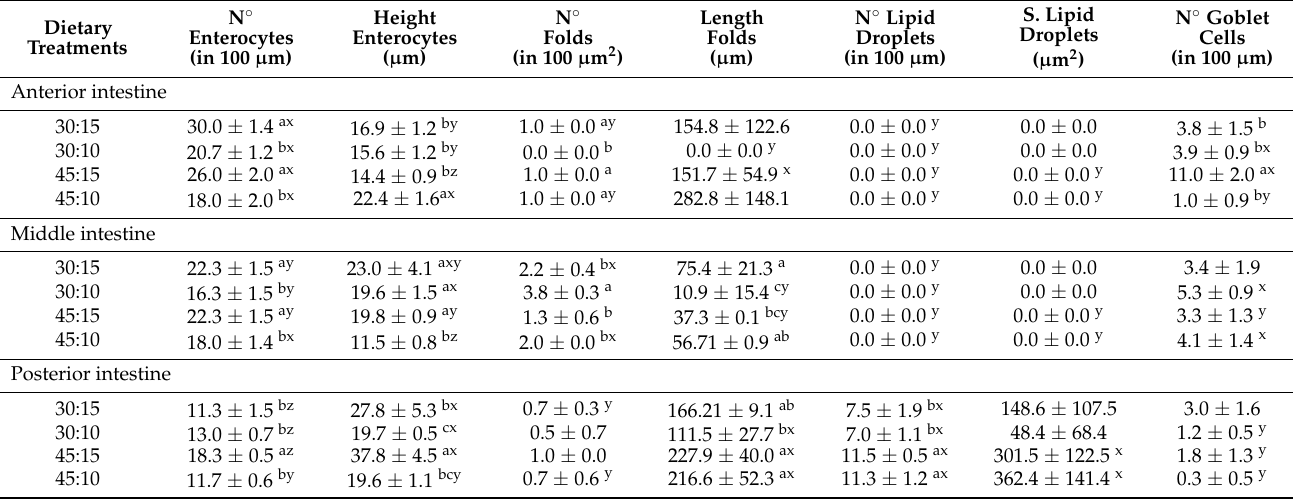
Table 8. Number and size of different components of the intestinal mucosa of P. punctifer specimens (26 dpf) fed the four different dietary treatments containing different protein:lipid levels (in % of dry matter). Data represent means ± S.D. of three replicate tanks for each dietary treatment ( n = 5 fish per replicate). Different letters from “a” to “c” within columns denote statistically significant differences among dietary treatments within the same intestinal section (one-way ANOVA, p < 0.05). Different letters from “x” to “z” denote statistically significant differences between intestinal sections within the same dietary treatment (one-way ANOVA, p <